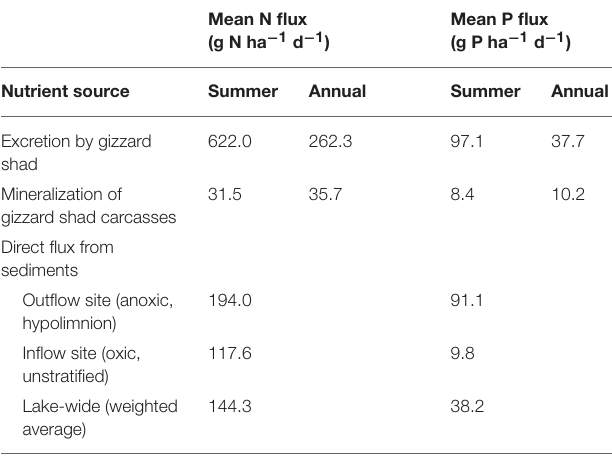
TABLE 2 | Comparison of different fluxes from sediments to water in Acton